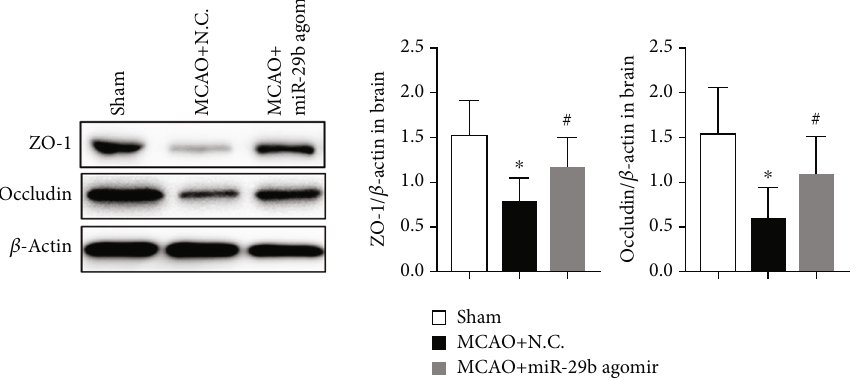
Figure 5: Protein expression of ZO-1 and occludin in the brain measured by Western blot. N = 6 . ∗ P < 0 : 05 vs. sham group; # P < 0 : 05 vs. MCAO+NC